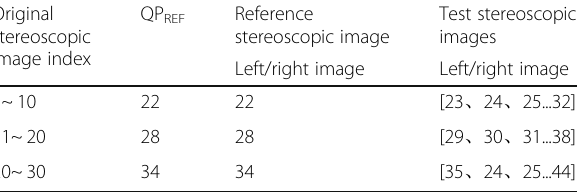
Table 6 The selection of QP for subjective experiment Original QP REF stereoscopic image index